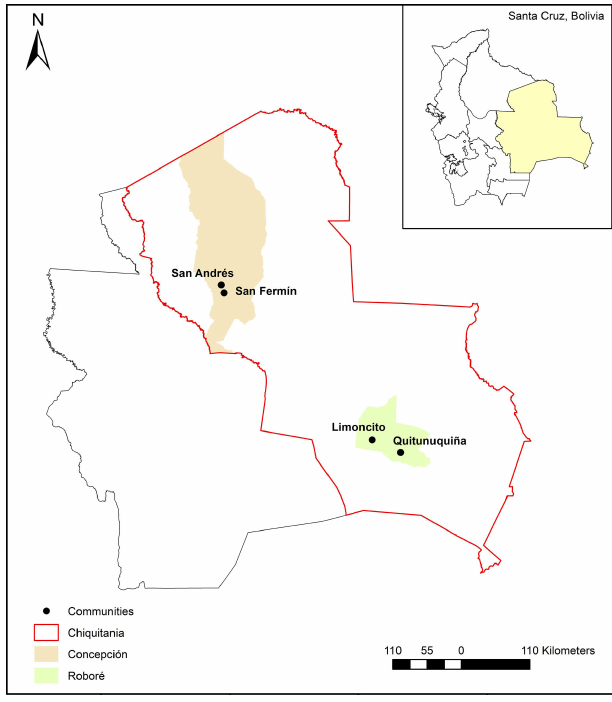
Fig. 1 . Our two study sites and the four communities interviewed in the Municipalities of Concepción and Roboré, Department of Santa Cruz, Bolivia. The boundaries of the Chiquitano Model Forest are delimited in red (IMFN